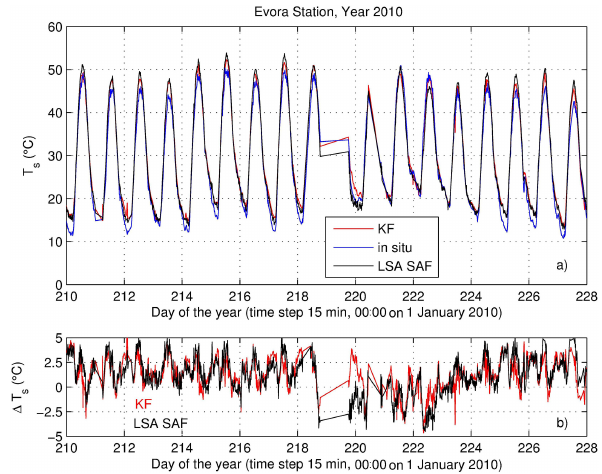
Figure 7. Evora station. (a) Example of T s time series for a few days in July 2010. (b) Difference (KF–in situ) and (LSA SAF–in situ).